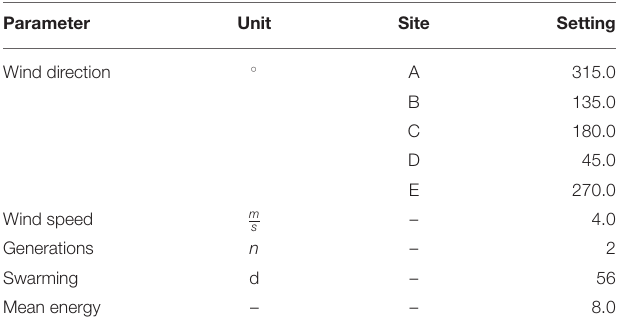
TABLE 6 | The settings of all parameters with high influence on direction, distance and amount of infested trees as used for the simulation experiments on testing the effectiveness of sanitation felling.